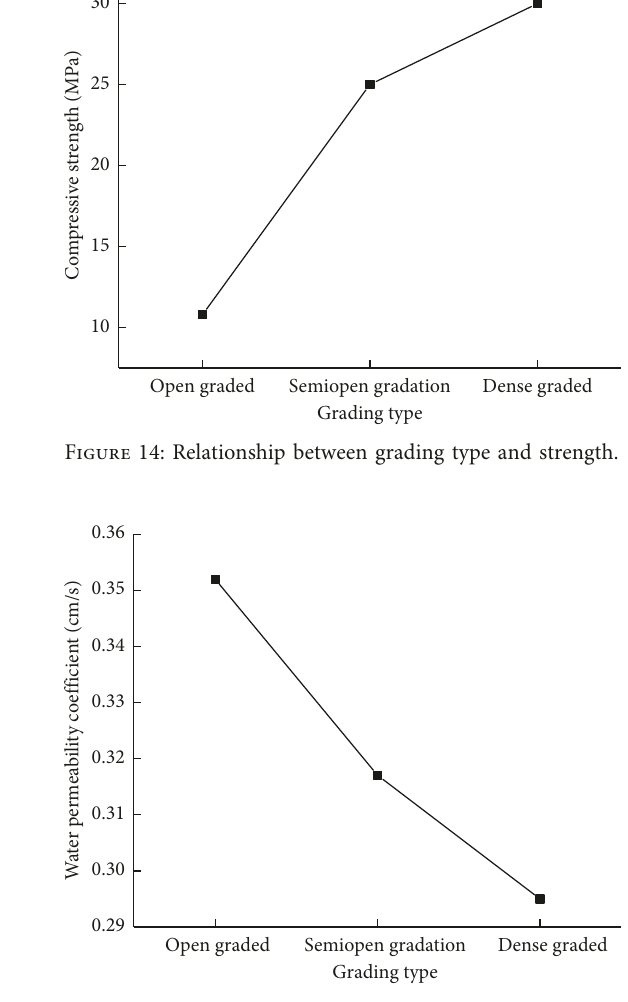
Figure 15: Relationship between grading type and permeability